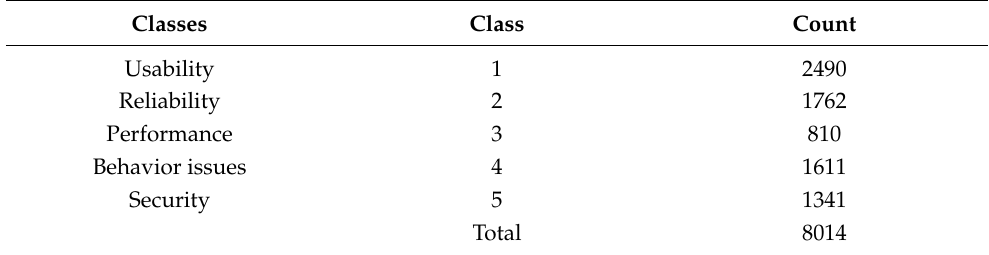
Table 5. Non-functional classes.